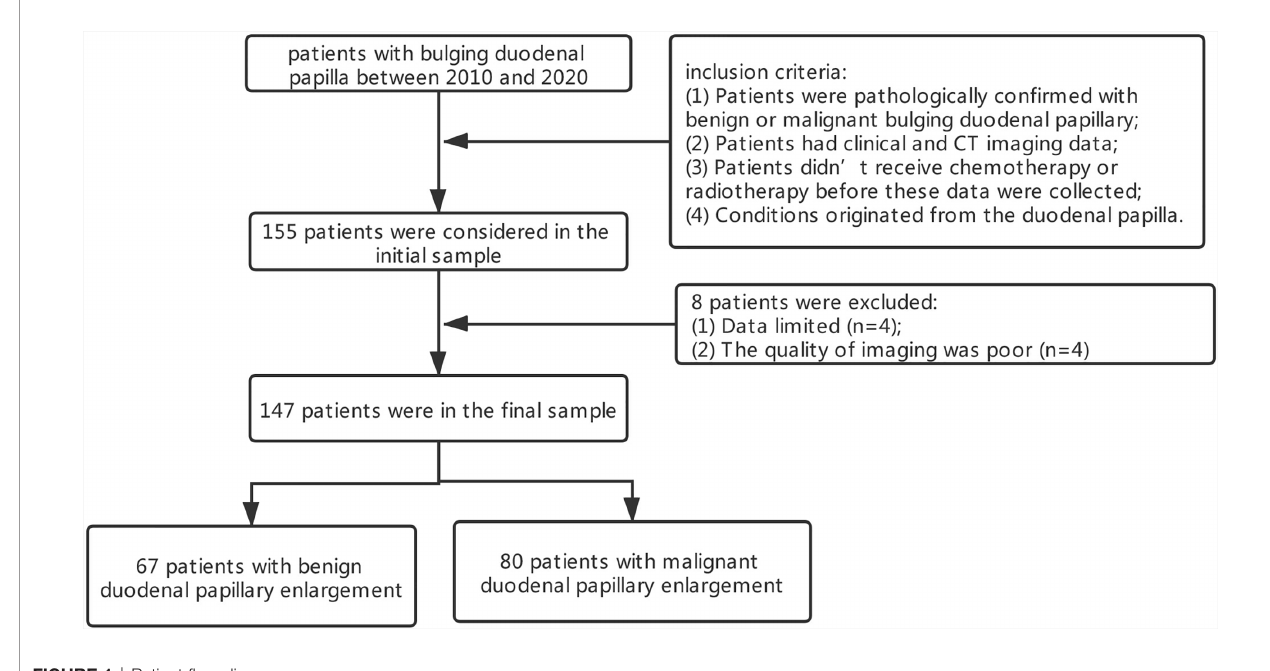
FIGURE 1 | Patient fl ow